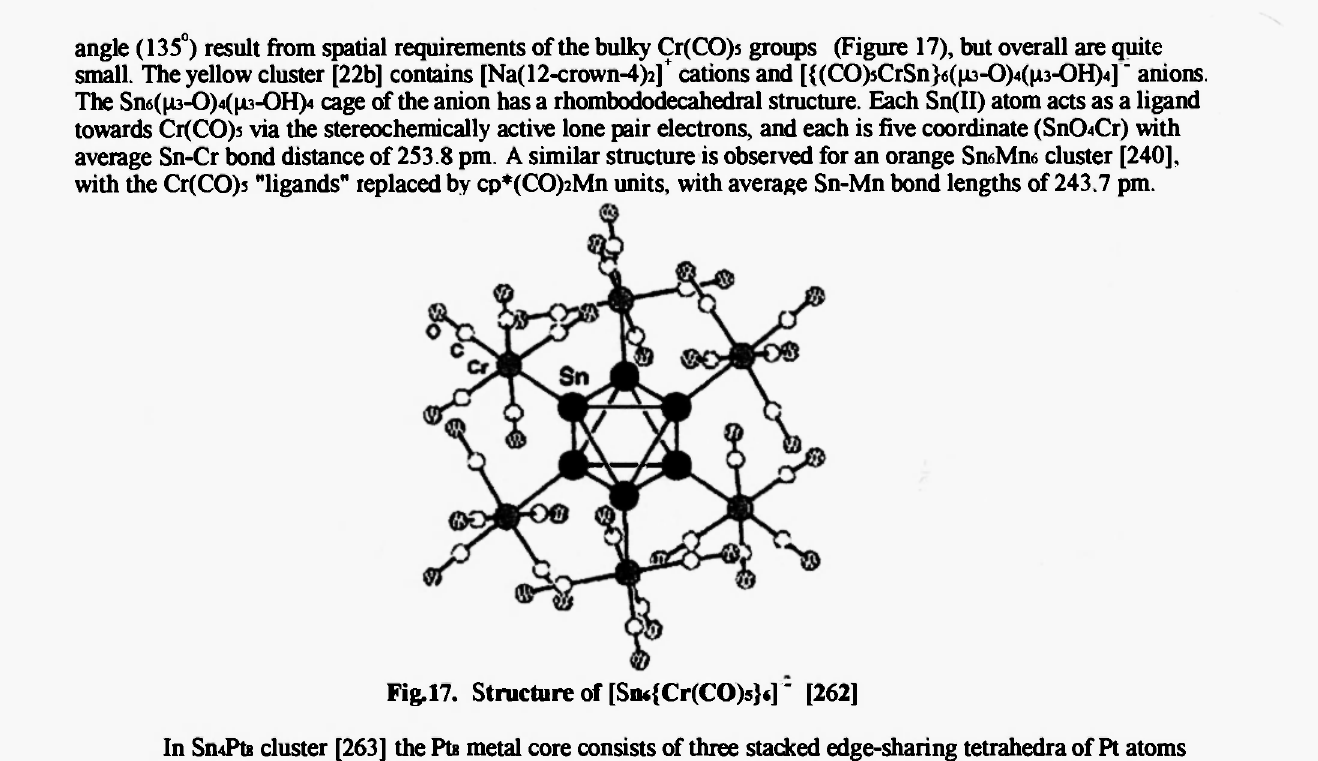
Fig. 17. Structure of [Snt{Cr(CO)5}«]